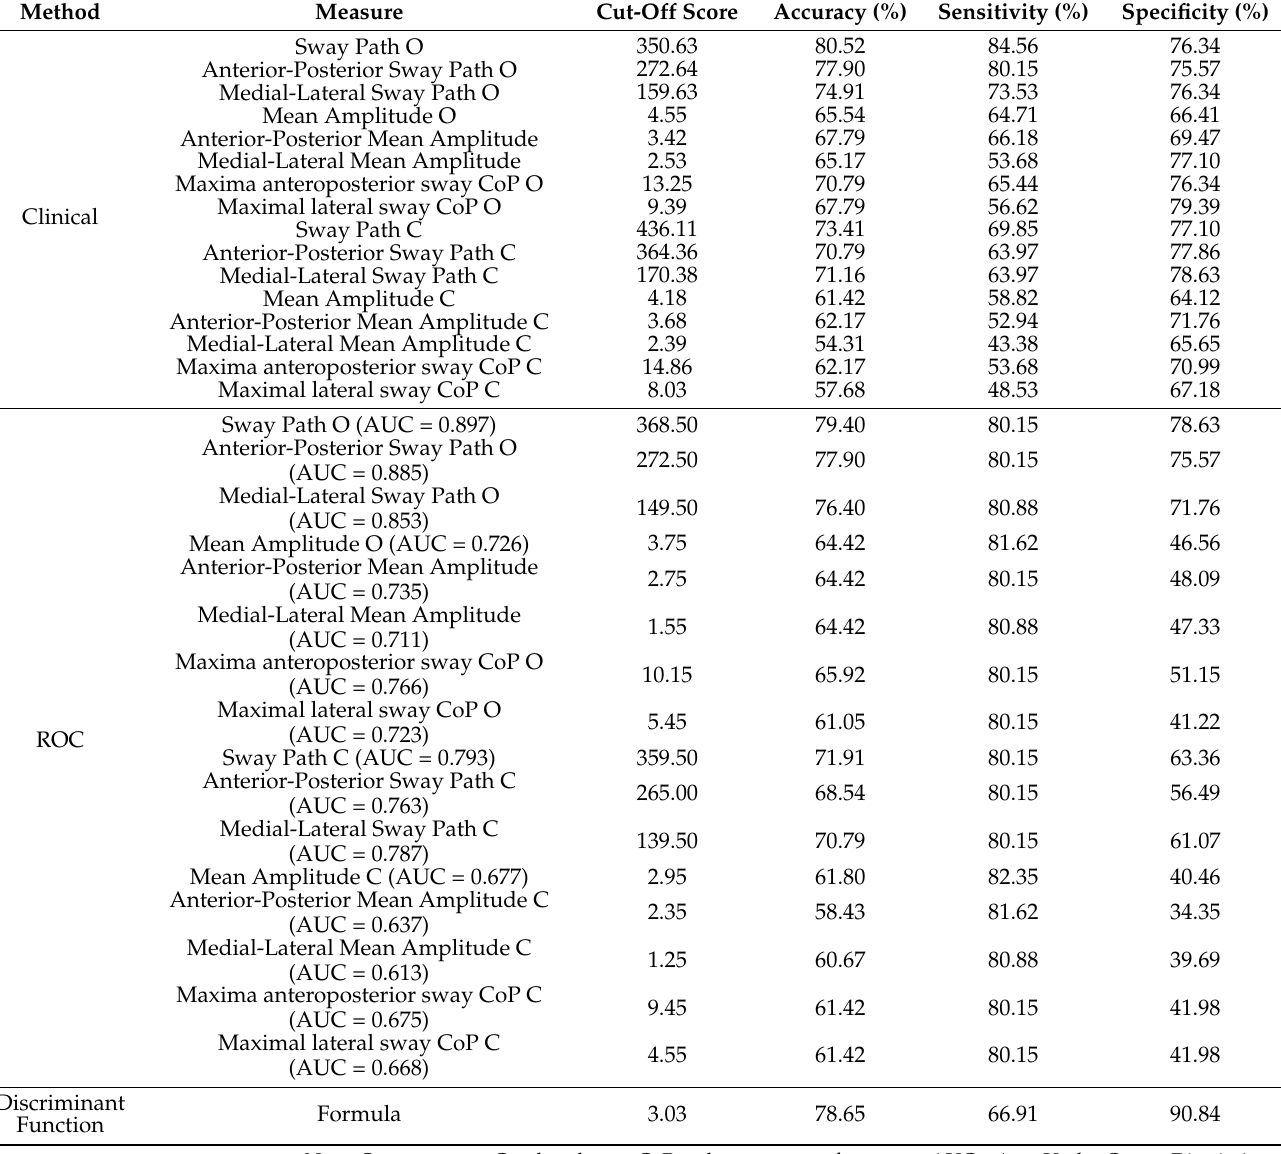
Table 3. Clinical, ROC, and discriminant function cut-off scores for a high risk for falling